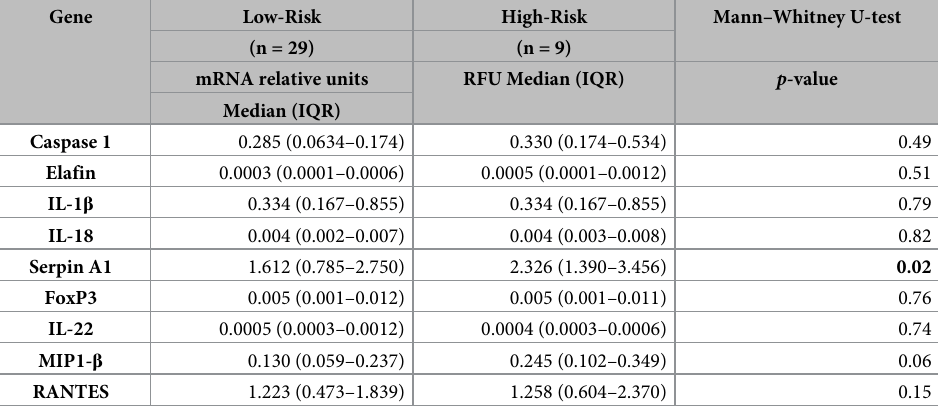
Table 3. mRNA gene expression in PBMCs of both MSM groups.